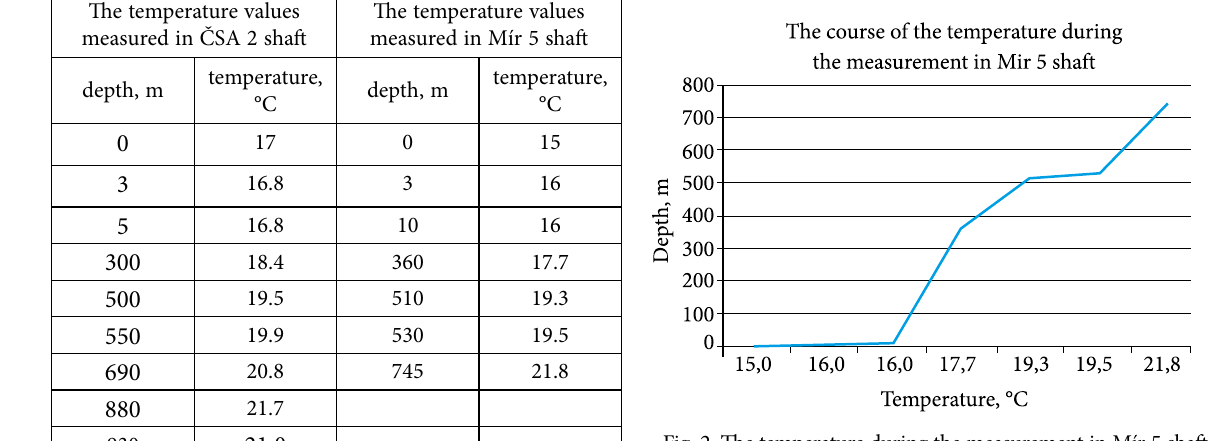
Fig. 2. The temperature during the measurement in Mír 5